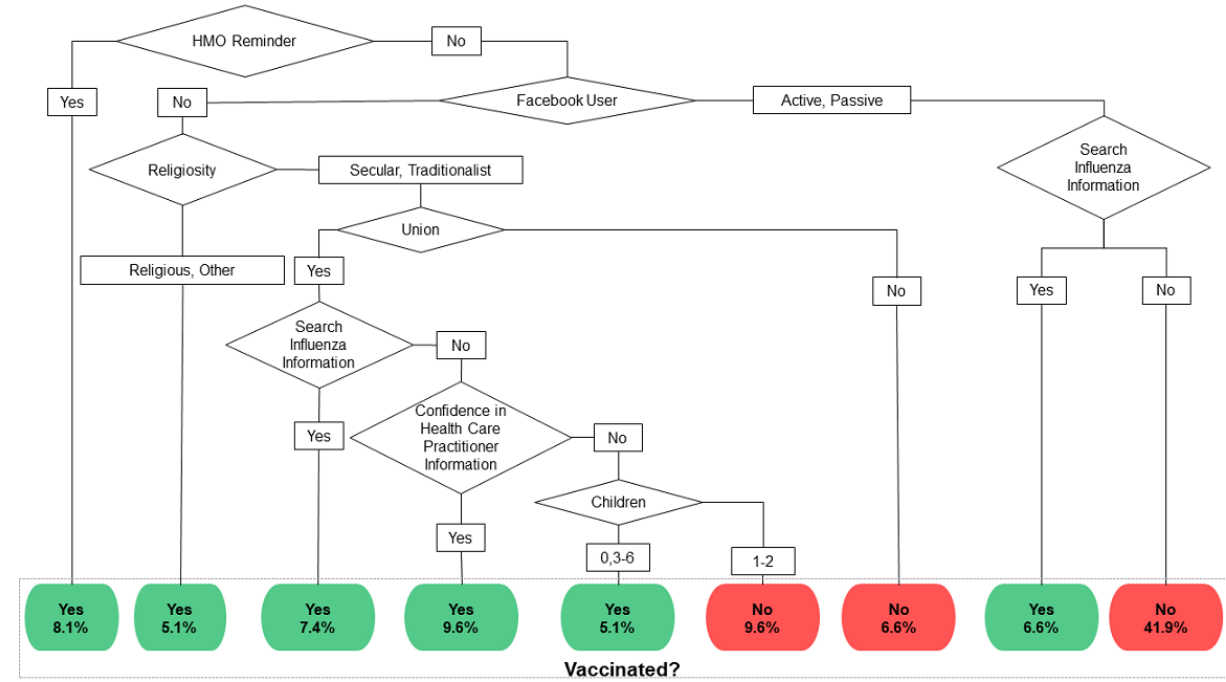
Figure 3. Decision tree predicting vaccinated individuals based on all survey attributes with P ≤ .10 and without the due to another reason attribute. HMO: health maintenance